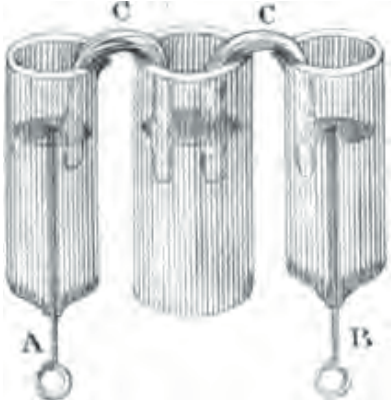
Figure 6. Drawing of Davy´s experimental arrangement for the study “ On the Passage of Acids, Alkalies, and other Substances through various attracting chemical Menstrua, by Means of Elec- tricity ”. It shows three glass tubes with platinum wires as poles in the two outer tubes A and B , which communicate with the mid- dle tube by strips of amianthus C (i.e. a fine silky asbestos), wet- ted with distilled water. The experiments are described in the text. It clearly confirms the migration of ions by electrophoresis. Taken from ref. [79]